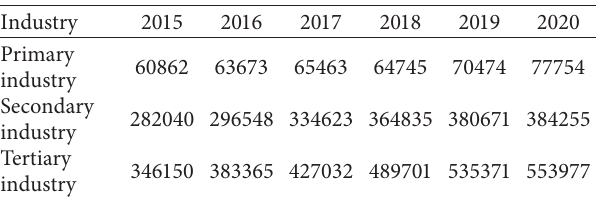
Table 4: Summary of employment contribution rate of three major